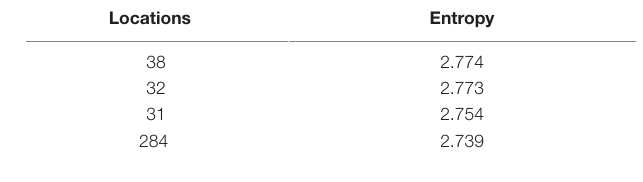
TaBle 4 | locations in order of decreasing entropy function.